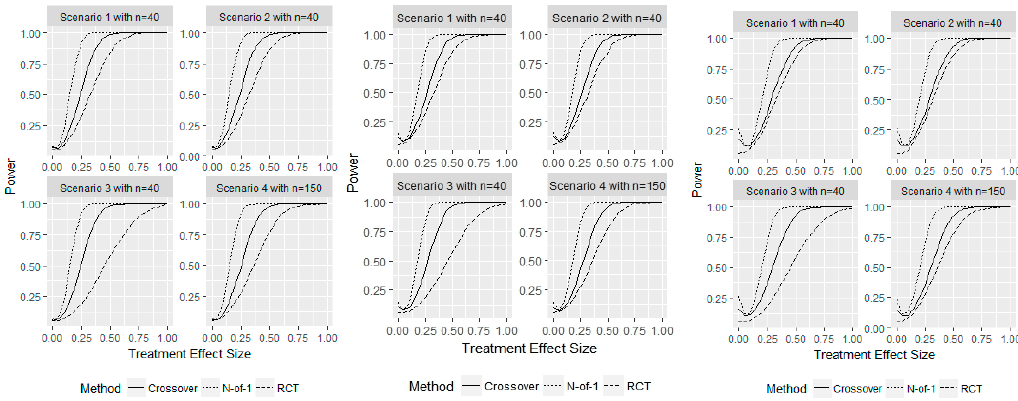
Figure 4. Simulation study for representative sample with a washout effect size of 0.05 (left), 0.10 (middle), and 0.15 (right). Displays the power for a fixed sample size 𝑛 with varying true treatment effects 𝜏 for the three different designs considered. The power for 𝜏 = 0 represents the type I error probability.